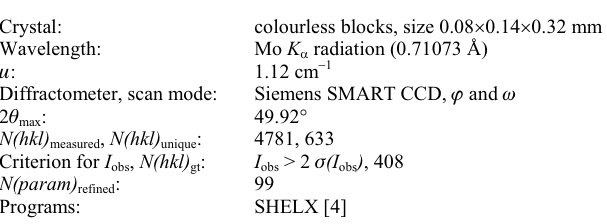
Table 1. Data collection and handling.